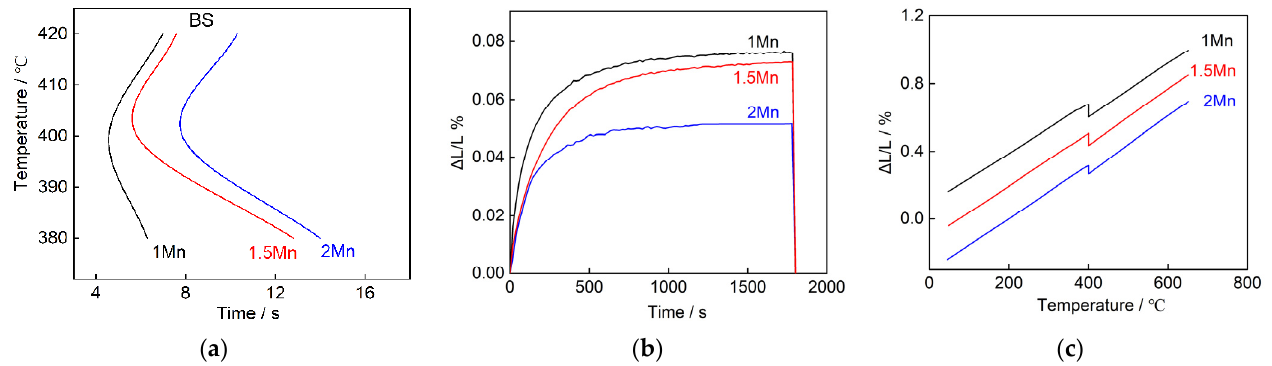
Figure 3. The dilatometry results of experimental steels. ( a ) Time-temperature-transformation (TTT) curves; ( b ) relative volume variation as a function of time during the bainite isothermal and subsequent cooling in process 3; ( c ) relative volume variation as a function of temperature during cooling in process 3.